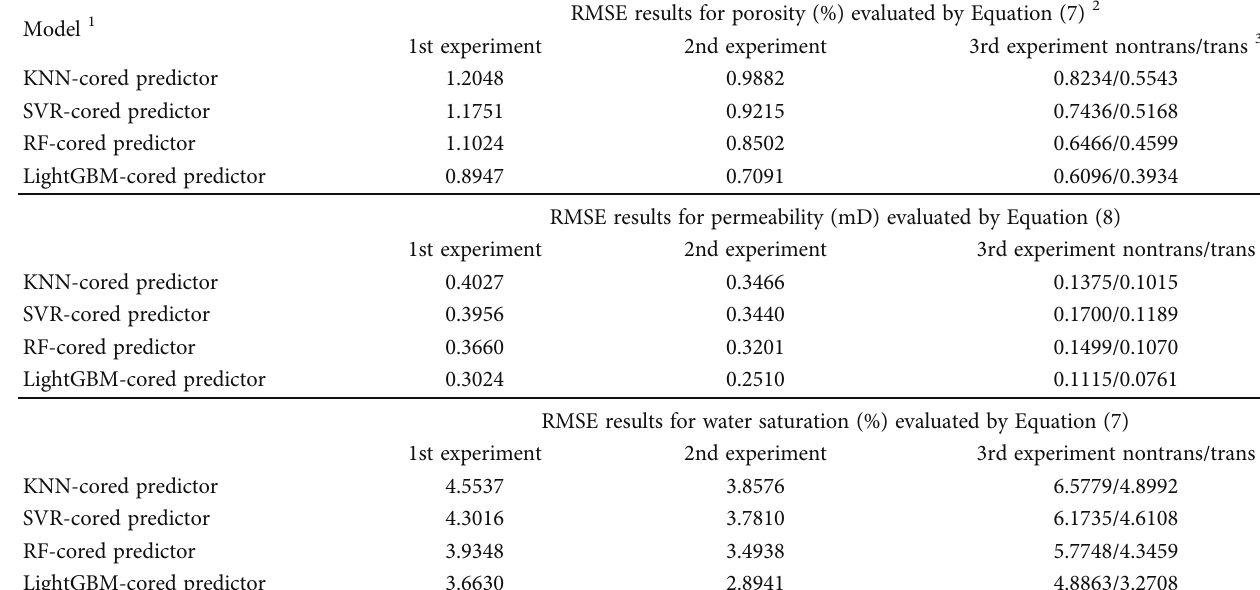
Table 6: Measured information of porosity, permeability, and water saturation gained by four validated predictors in three experiments. Model